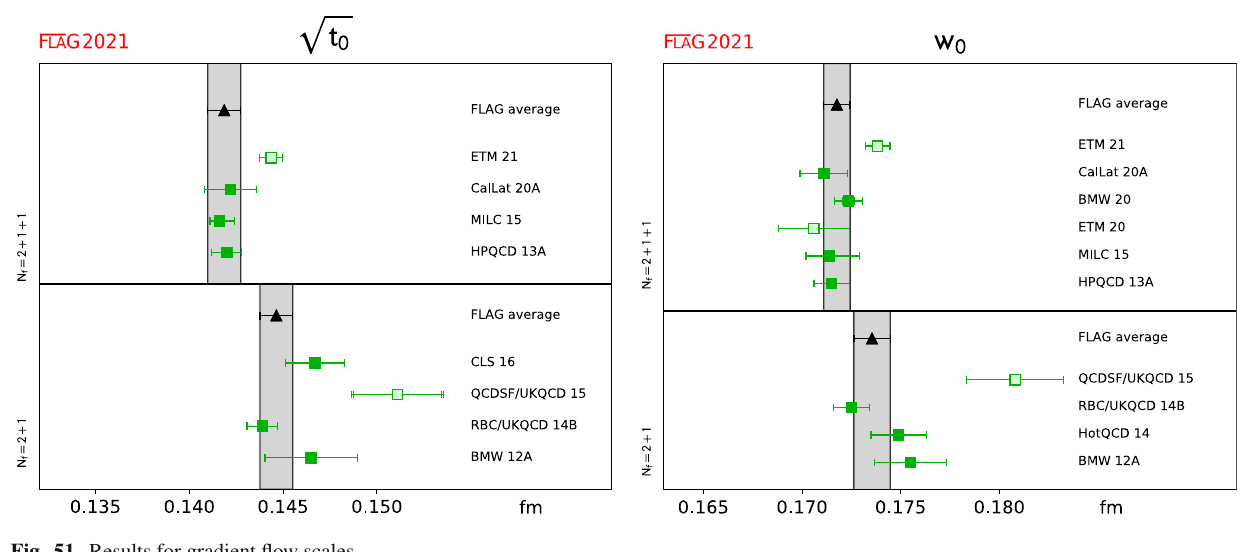
it is demonstrated how the effective masses of the (cid:12) correlator almost reach the plateau value extracted from a four-state fit (two states per parity). Within the range where the data is fitted, the deviation of data points from the estimated plateau is less than a percent. Isospin-breaking corrections are computed by Taylor expansion around isoQCD with QED treated as QED Finite volume effects in QED are taken from the 1 / L , 1 / L 2 universal corrections and O ( 1 / L 3 ) effects are neglected. The results for M (cid:12) w 0 are extrapolated to the continuum by a fit with a 2 and a 4 terms. ETM 20 [1052] presents in their proceedings contribution a preliminary analysis of their N f = 2 + 1 + 1 Wilson twisted- mass fermion simulations at maximal twist (i.e., automatic O ( a ) improved), at three lattice spacings and pion masses at the physical point. Their determination of w 0 = 0 . 1706 ( 18 ) fm from f π using an analysis in terms of M π is the value quoted above. They obtain the consistent value w 0 = 0 . 1703 ( 18 ) fm from an analysis in terms of the renormalized light quark